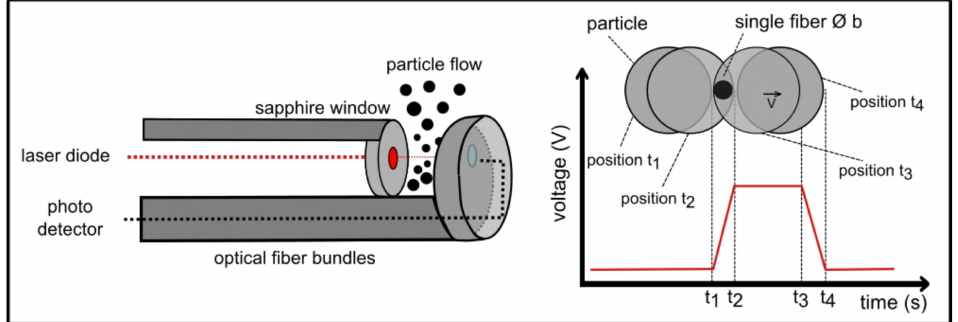
Figure 10. Spatial filtering technique. The sensor setup is shown on the left, and voltage impulse generation by fiber-optic spot scanning is shown on the right